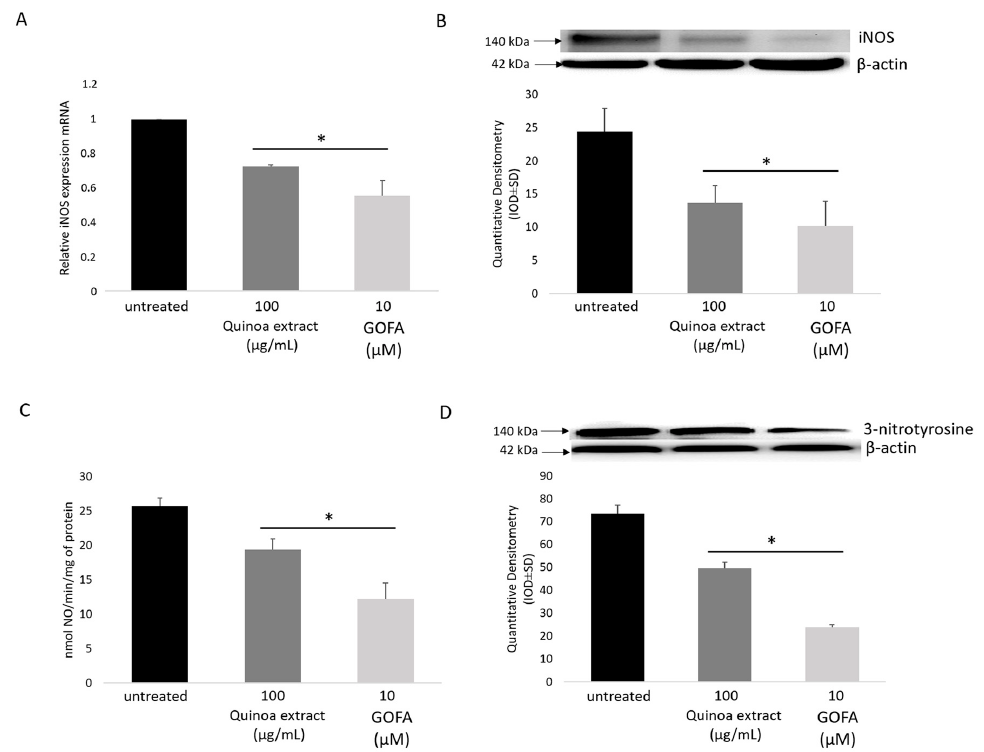
Figure 3. The effects of quinoa and GOFA on iNOS/NO/3-NitroTyrosine signaling in HCT-116 cells. The effects of quinoa extract and GOFA on: ( A ) iNOS mRNA levels, ( B ) iNOS protein expression. ( C ) NO production. ( D ) 3-nitrotyrosine protein expression. Each bar represents mean ± SD ( n = 3, * p < 0.01 vs. untreated cells).